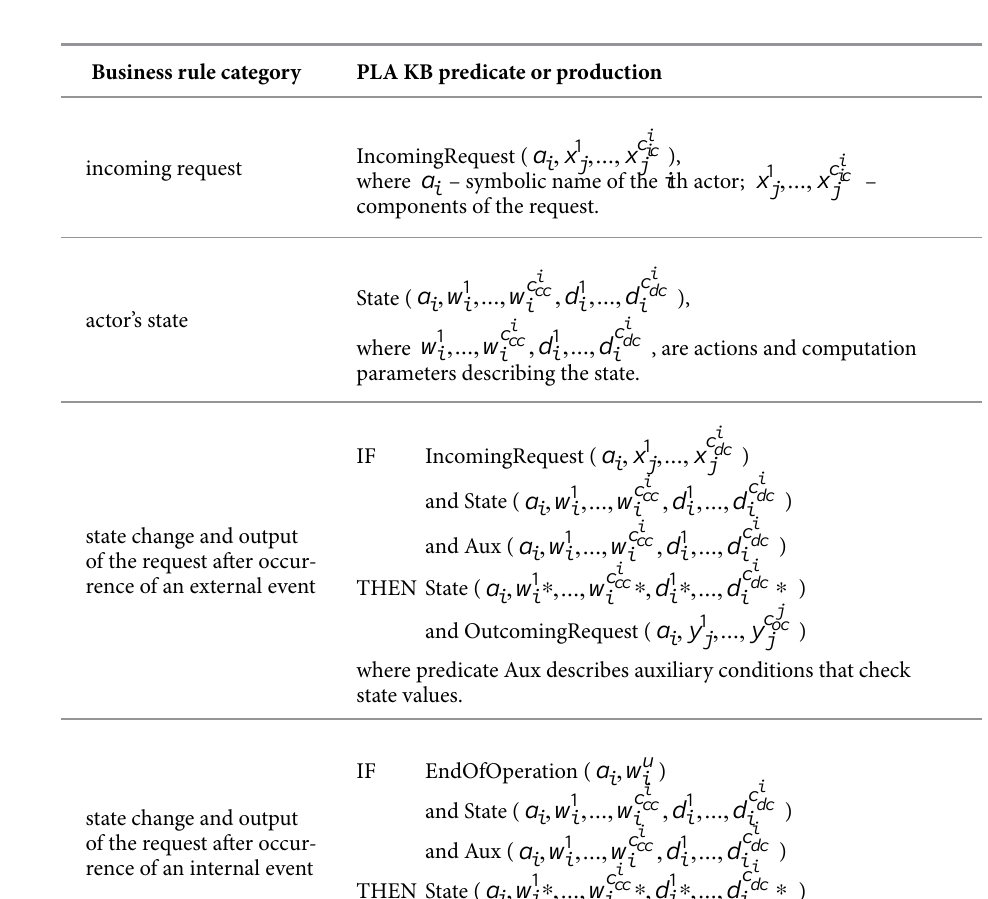
table 1. Examples of business rule categories and their representation by PLA KB